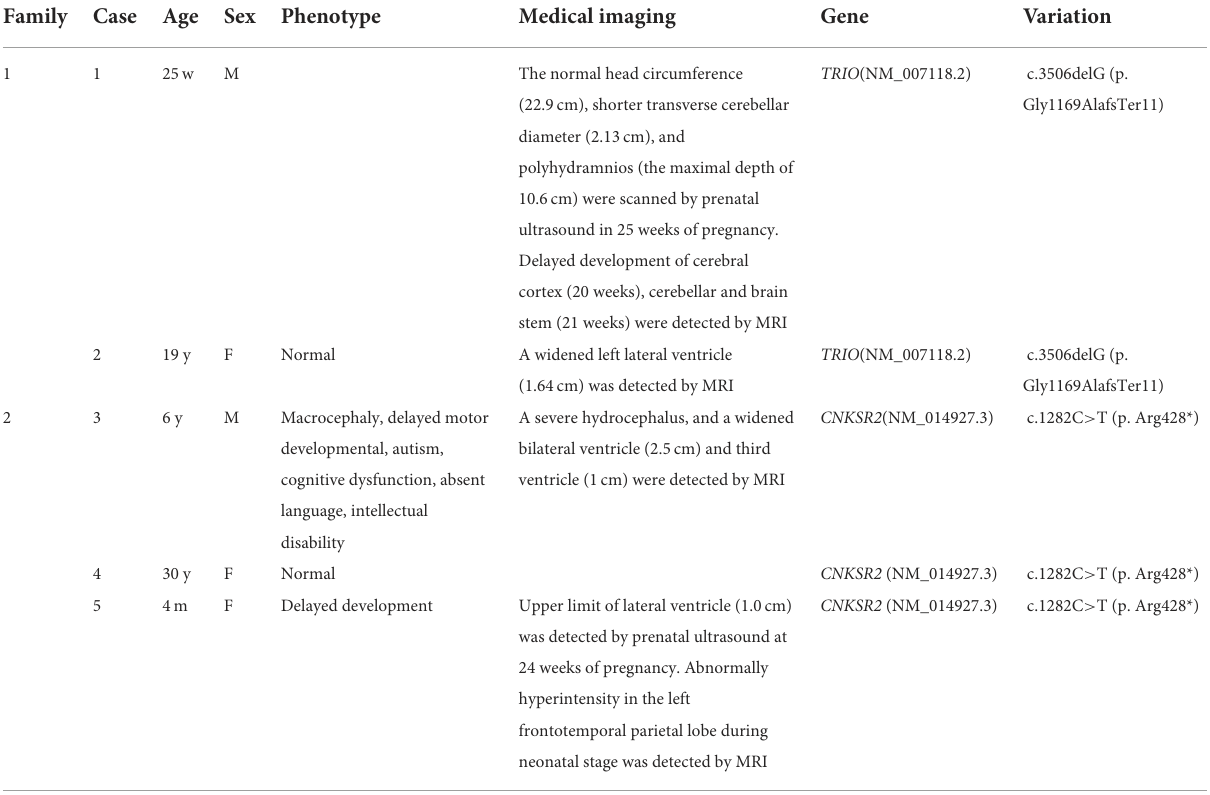
TABLE 1 Clinical phenotype and related gene variations identified in two families with neurological